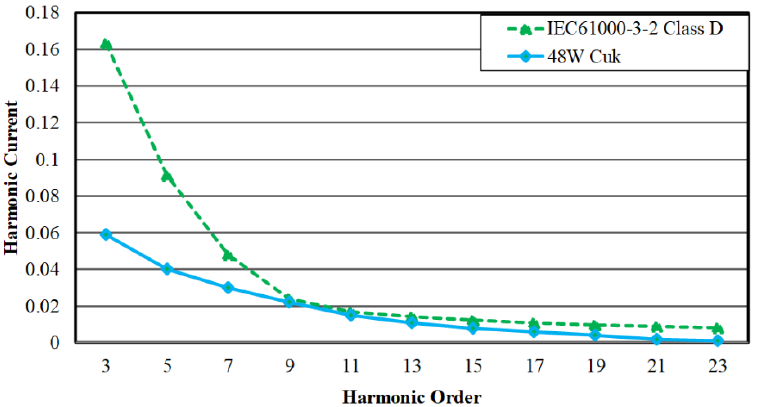
Figure 24. The measured harmonic distribution of the input current compared with IEC61000-3-2 Class